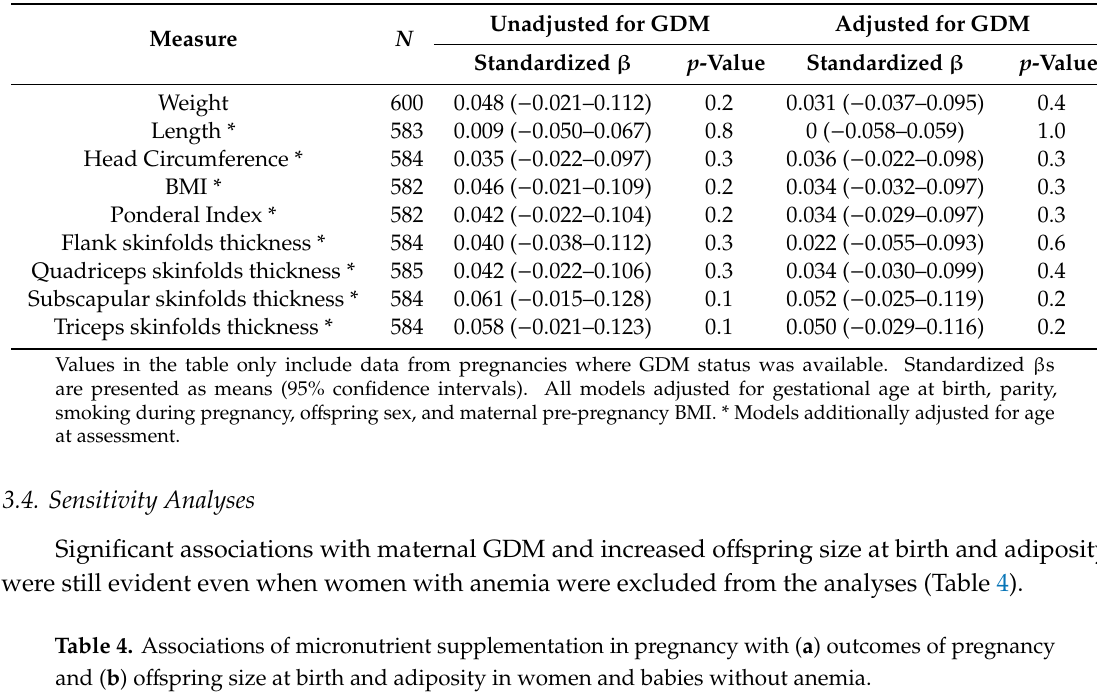
Table 3. Subgroup comparison assessing the e ff ect of GDM on associations between multiple micronutrient supplementation in pregnancy and size at birth.